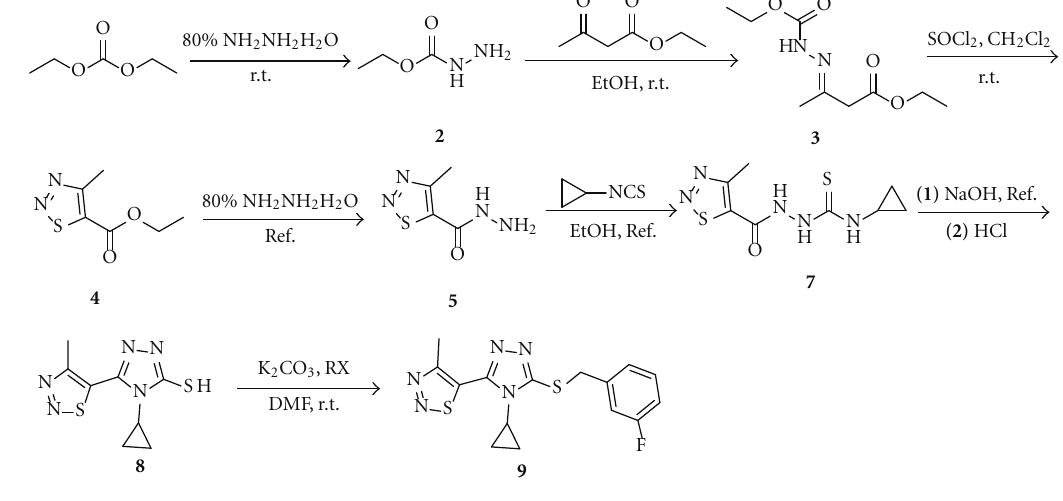
S 1: e synthetic route of title compound.